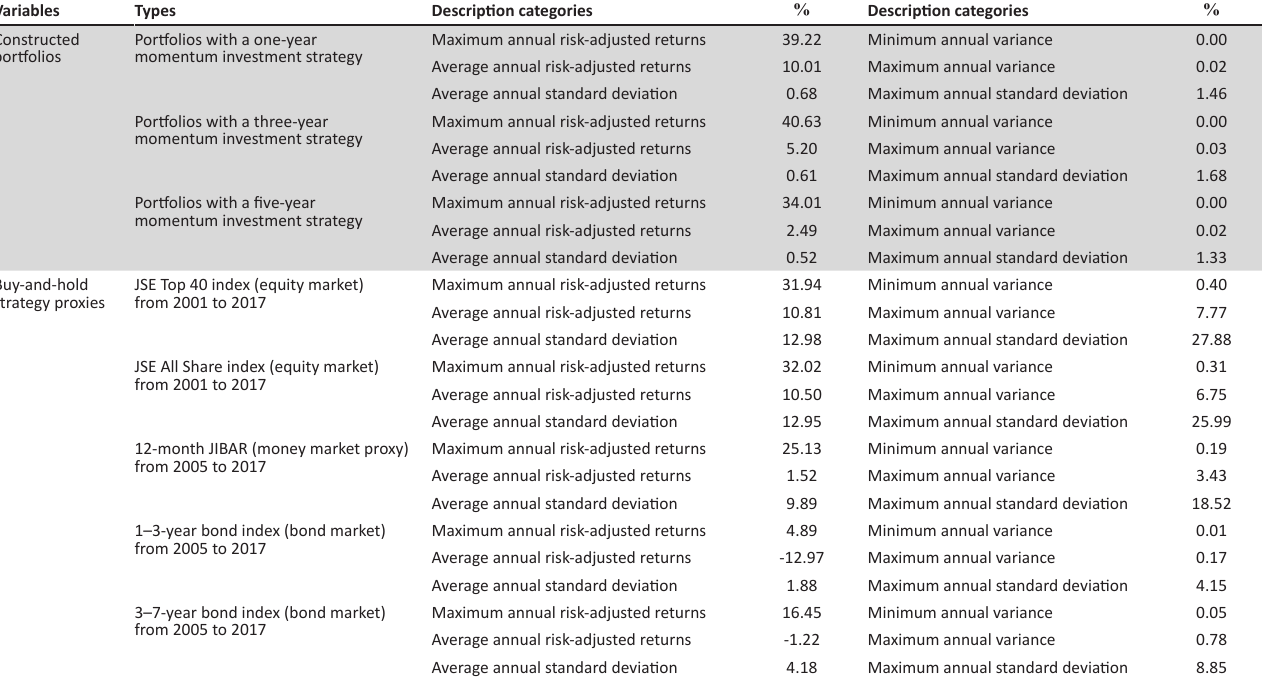
TABLE 3: Portfolio composition